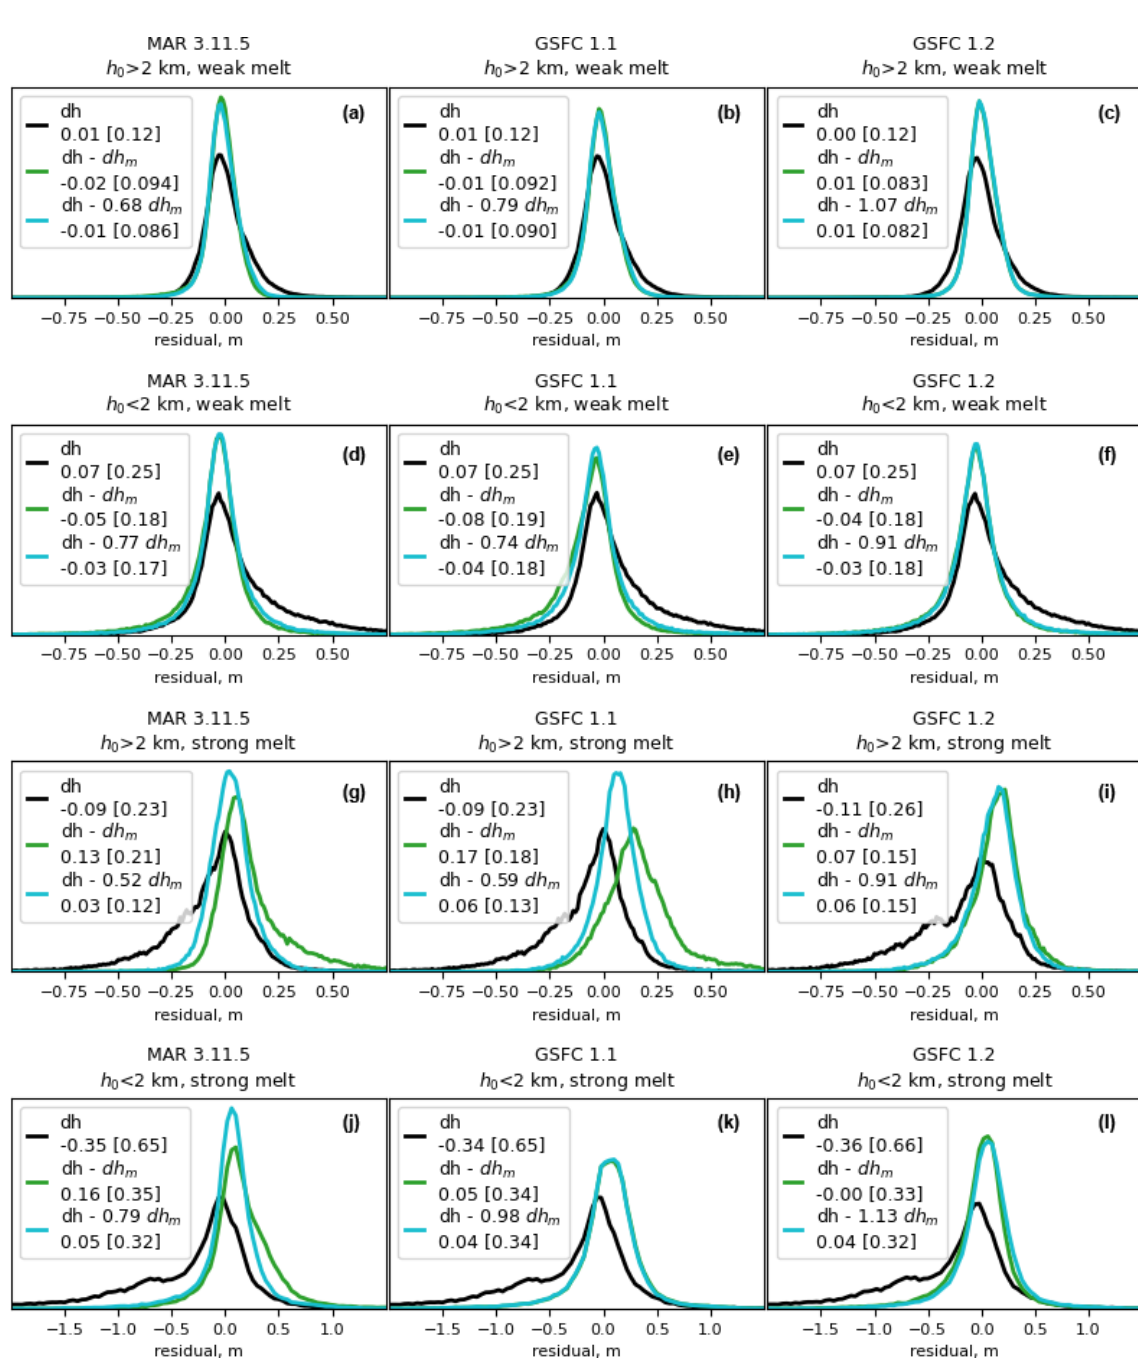
The Cryosphere, 17, 789–808,